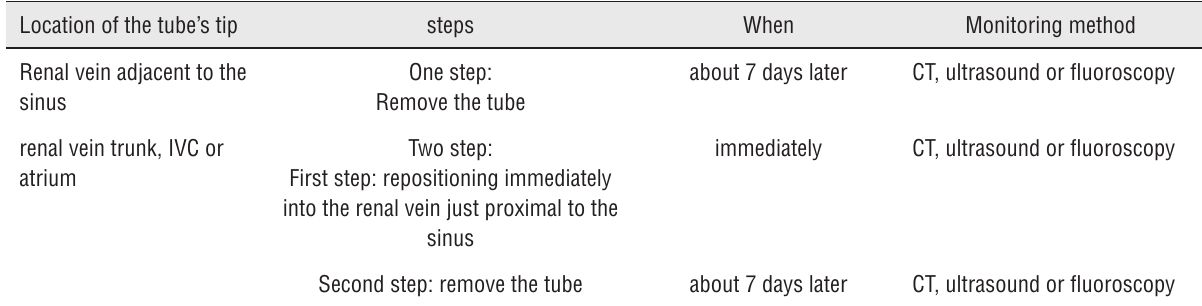
Table 2 - The procedure of managing an intravenously misplaced nephrostomy tube. Location of the tube’s tip steps Monitoring